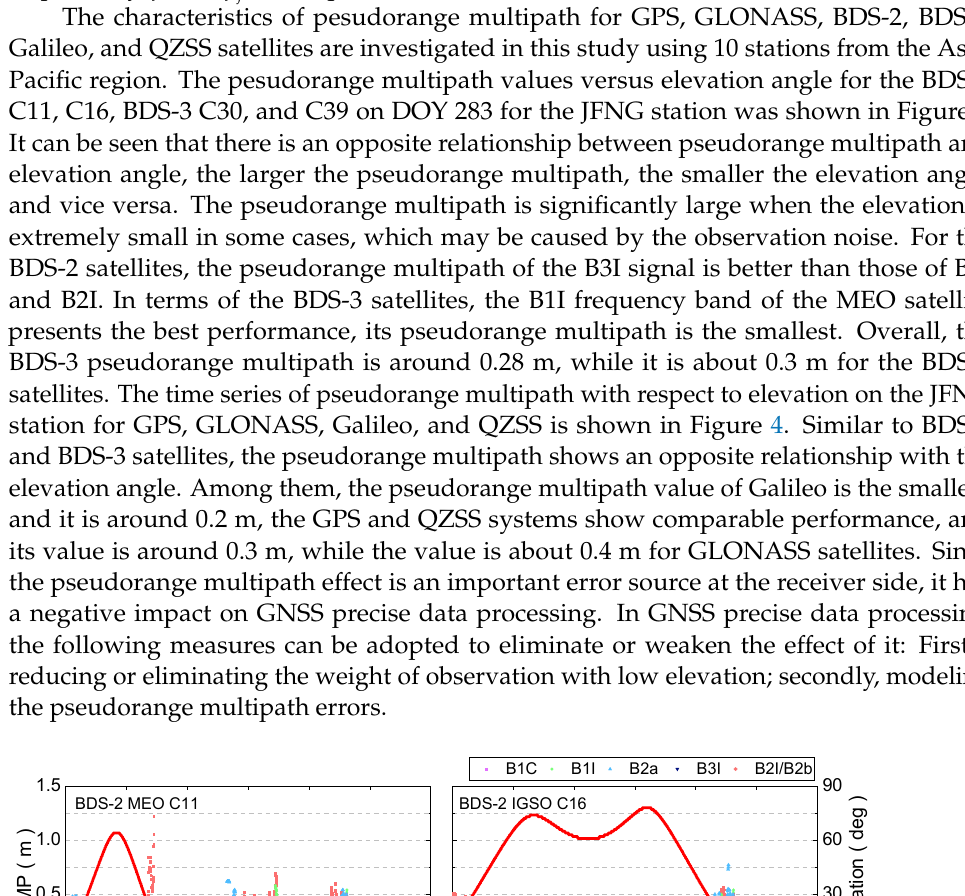
Figure 4. The MP series of GPS/QZSS/GLONASS/Galileo for DOY 283 on JFNG station. (The red wave indicates the sequence of elevation angle).